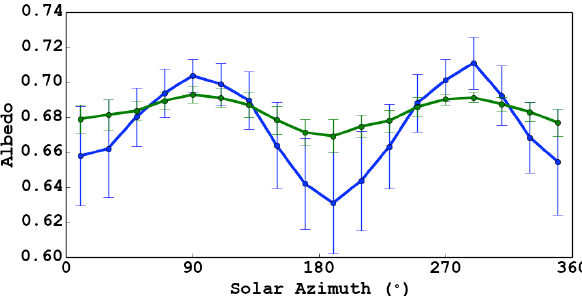
Figure 11. Mean TOA albedo and standard deviation as a function of solar azimuth angle using clear footprints in a South Pole region (88–89 ◦ S, and 76–83 ◦ W) during all Decembers of 2000–2004, for θ 0 = 65–70 ◦ . The blue line shows albedos calculated using the ADMs from Loeb et al. (2005) and the green line shows albedos calculated with the new